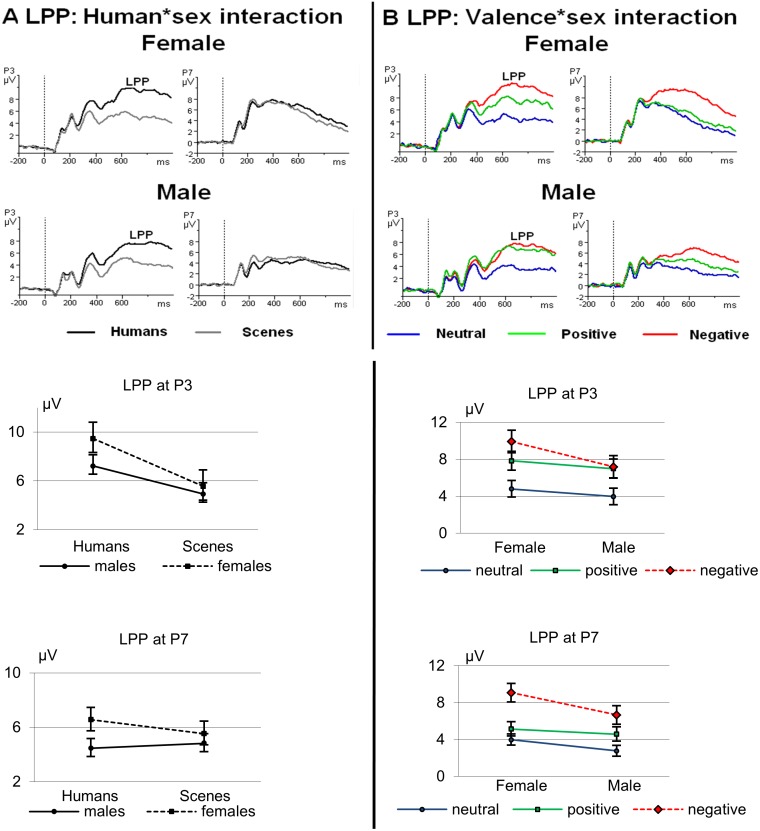
ERPs of parietal electrodes (P3 and P7) depicting the Human*Sex and the Valence*Sex interaction.Below the ERPs showing the grand averages for pictures with and without humans collapsed for valence (A) and for pictures with the different valences collapsed for human presence (B). The corresponding line graphs with mean amplitudes (and SEMs) of the 550 to 700 ms interval illustrate the interactions found.